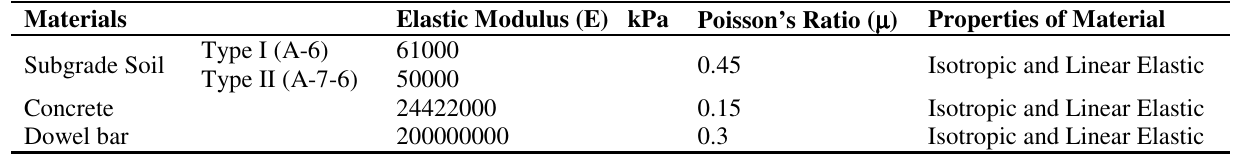
The Material Properties used in ABAQUS Models.